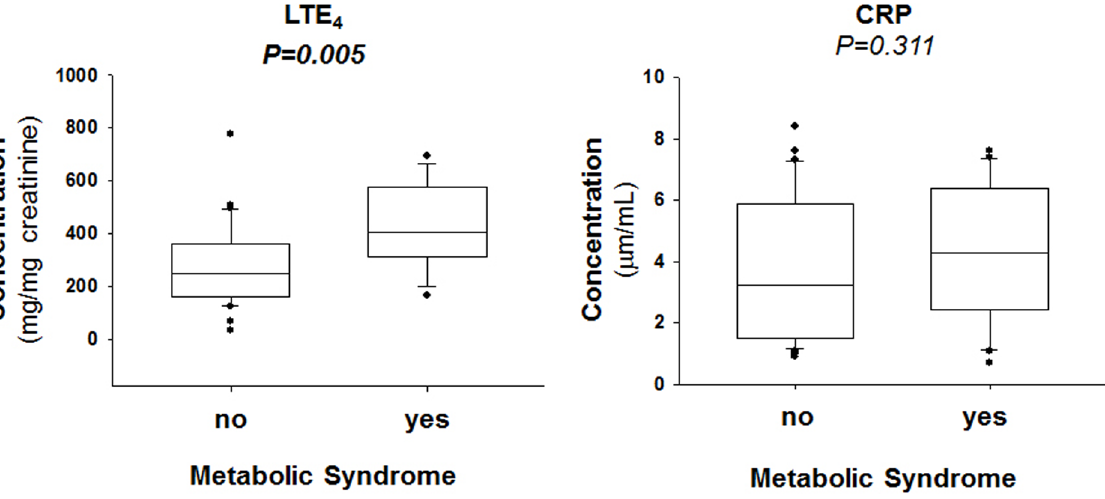
Figure 1. Urinary leukotriene E 4 (LTE 4 ; upper panels) and serum C-reactive protein (CRP; lower panels). Waist/Hip Ratio was categorized as either low ( n 5 19) or high (men . 0.9; women . 0.85; n 5 26). Triglyceride levels were categorized as either low ( n 5 26) or high ( . 1.7 mmol/L; n 5 20). HDL levels were categorized as either high ( n 5 22) or low ( , 1.0 mmol/L for men, and , 1.3 mmol/L for women; n 5 24). Hypertension was defined as systolic blood pressure . 130 mmHg, mean arterial pressure . 85 mmHg or anti-hypertensive treatment ( n 5 19). Fasting blood glucose was categorized as either low ( n 5 38) or high ( . 5 mmol/L; n 5 8). P -value (obtained by means of Mann-Whitney Rank Sum Test) in bold font indicates P ,